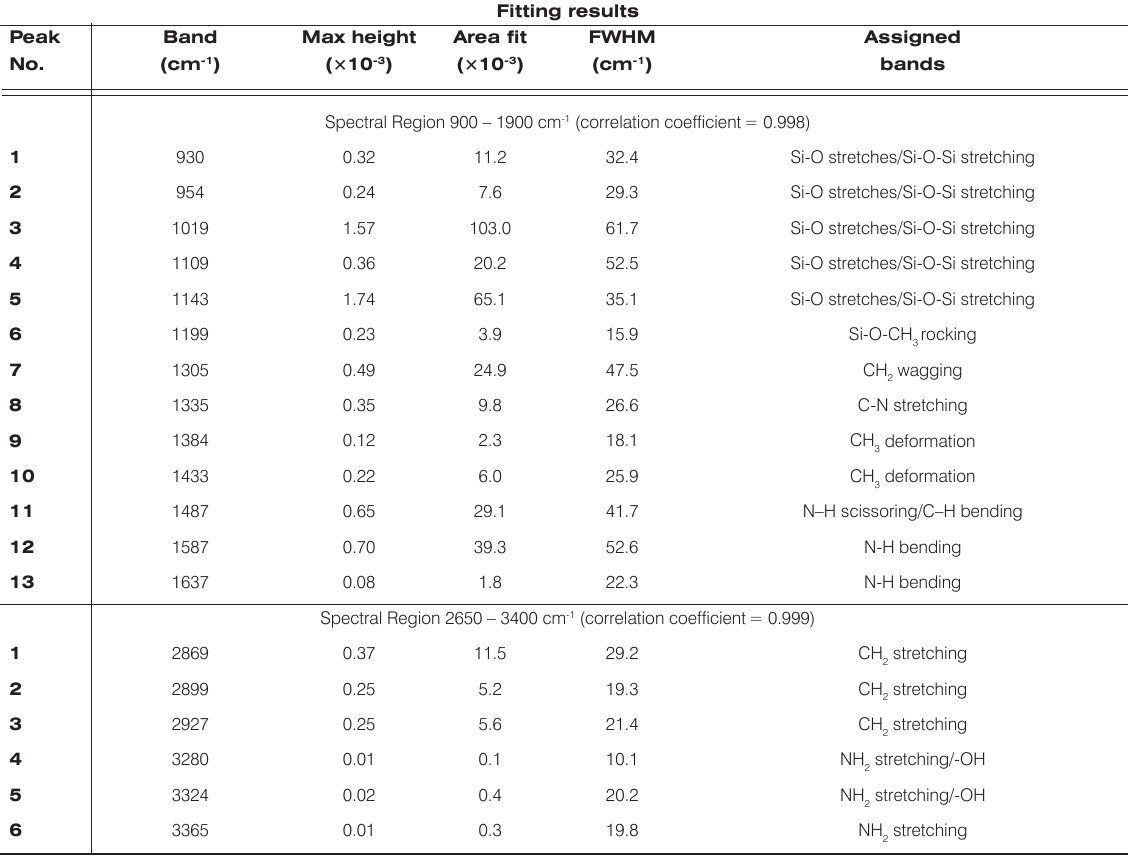
Table 1. Peak assignments for 3-aminopropyltriethoxysilane functionalized